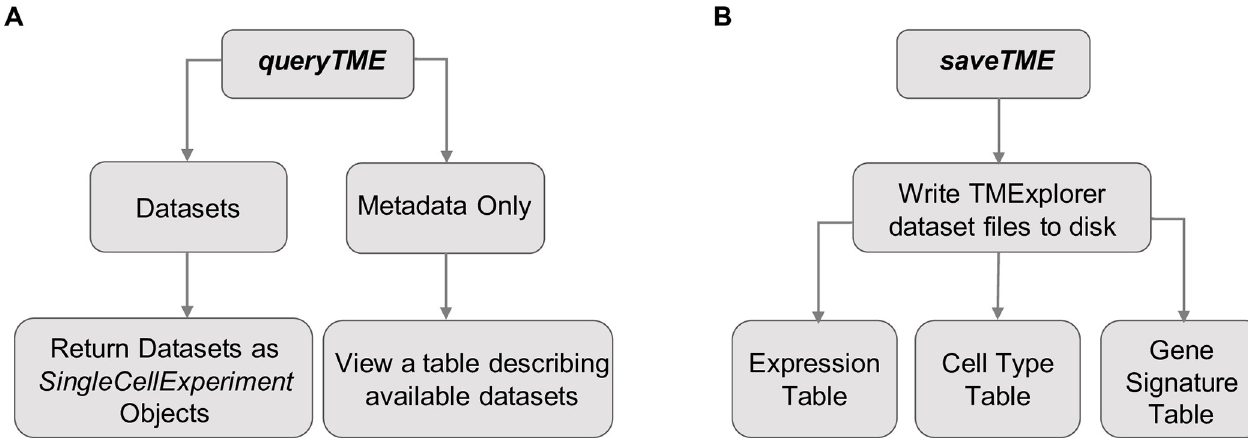
Fig 3. An overview of the main functions of TMExplorer. A. queryTME allows users to search and return datasets in either a descriptive table or as a list of SingleCellExperiment objects for analysis. B. saveTME allows users to write datasets to disk. For each dataset written to disk, up to three files are created; a table storing the expression data as either a CSV or matrix market file, depending on whether a dense or sparse matrix is passed to the function; a table containing the cells and their truth label, if available; and a table containing the cell type signature gene sets, if available.